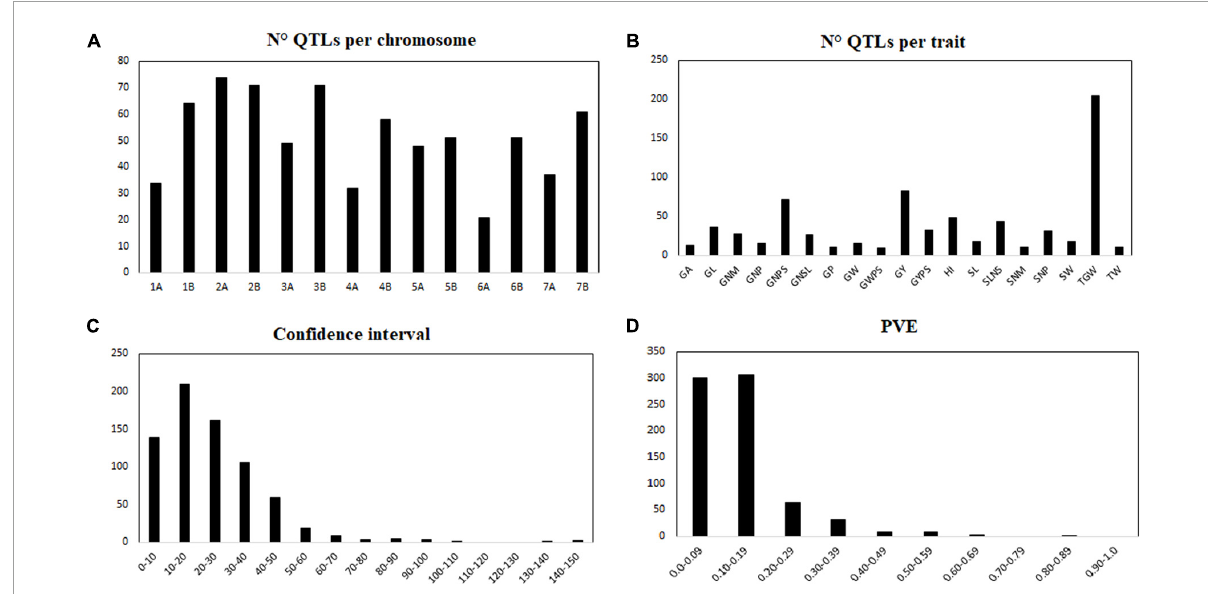
FIGURE1 Description of the 724 collected QTLs. Number of QTL per chromosome (A) , number of QTL per trait (B) , confidence interval (C) , phenotypic variance explained (PVE) for each QTL (D) . GA, grain area; GL, grain length; GNM, grain number per m 2 ; GNP, grain number per plant; GNPS, grain number per spike; GNSL, grain number per spikelet; GP, grain perimeter; GW, grain width; GWPS, grain weight per spike; GY, grain yield; GYPS, grain yield per spike; HI, harvest index; SL, spike length; SLNS, spikelet number per spike; SNM, spike number per m 2 ; SNP, spike number per plant; SW, spike width; TGW, thousand grain weight; TW, test weight.